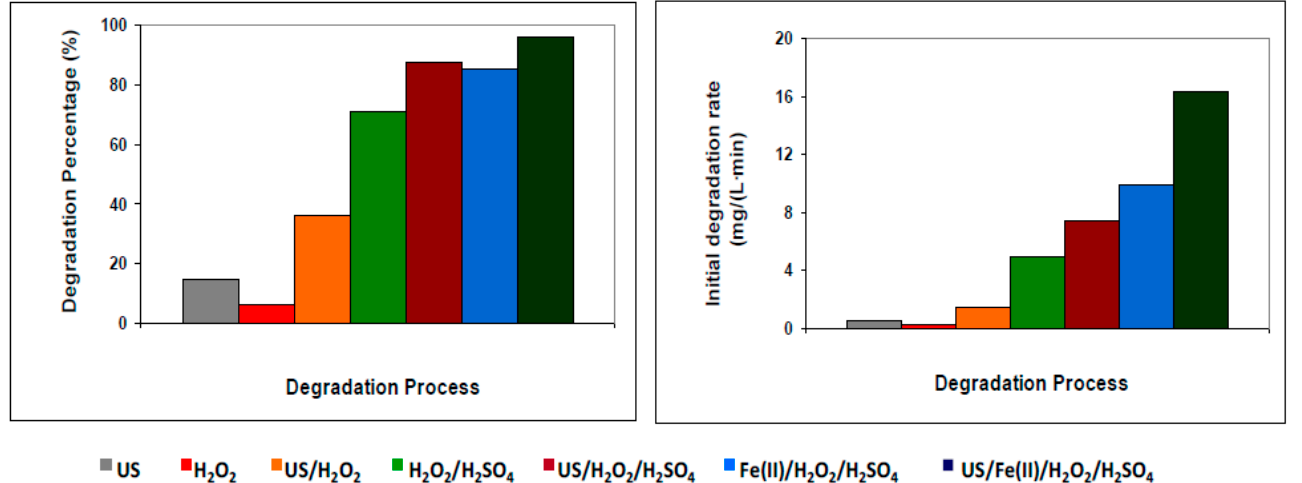
Figure 4. Degradation percentages and initial degradation rates of Acid Brown 83 by different degradation methods.